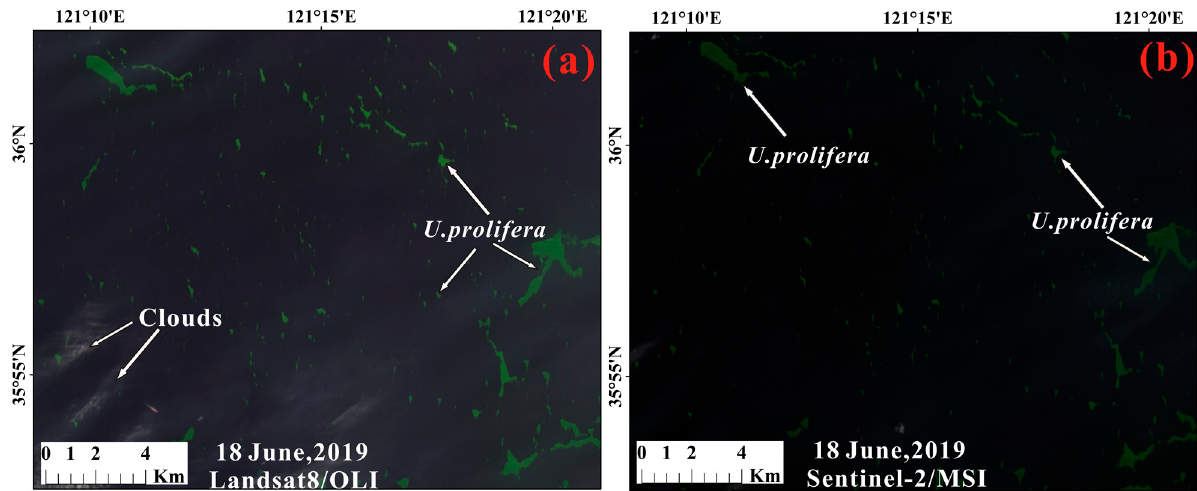
Figure 5. A visual interpretation of the satellite Red-Green-Blue “true-color” composite image recorded by Landsat8/OLI and Sentinel-2/MSI. ( a ) Landsat8/OLI true-color image on 18 June 2019, R:G:B = band 4:3:2, ( b ) Sentinel-2/MSI true-color image on 18 June 2019, R:G:B = band 4:3:2.